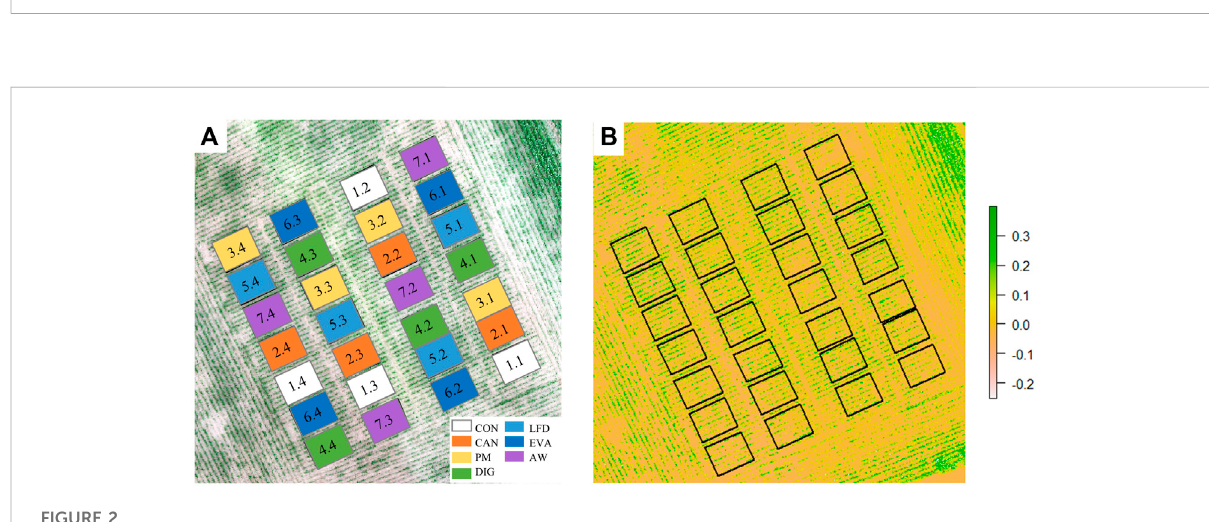
FIGURE 1 The values of mean ± standard deviation ( n = 4) for (A) fresh weight (FW), (B) dry weight (DW), (C) the N concentration (% DW) and (D) the N uptake (kg ha − 1 ) of maize crop at sampling moments T3(18August 2020) and T4 (22 September 2020). The lowercase and uppercase letters refer to the statistical difference between treatments at T3 and T4, respectively, using one-way ANOVA and Fisher ’ s Least Signi fi cant Difference (LSD) post- hoc pairwise comparisons at a 5% level. CON, no-N control; CAN, calcium ammonium nitrate; PM, pig manure; DIG, digestate; LFD, liquid fraction of digestate; EVA, evaporator concentrate; AW, ammonia